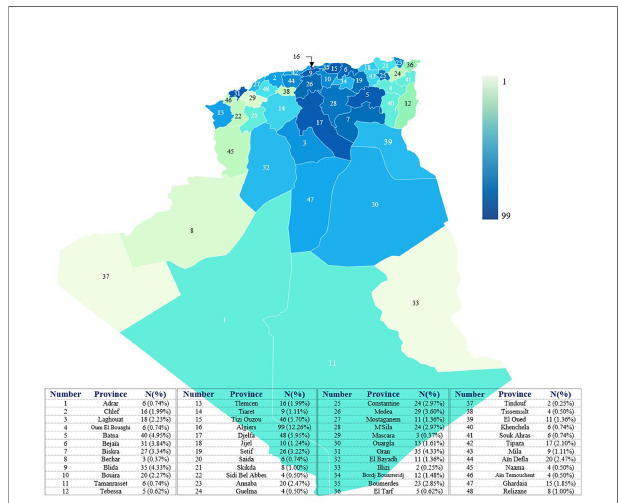
FIGURE 5 | distribution of patients in the different provinces of Algeria. The base map was created with the permission of data wrapper. The intensity of the blue color is proportional to the number of patients. The registered number includes living and deceased patients. Each number on the map corresponds to a